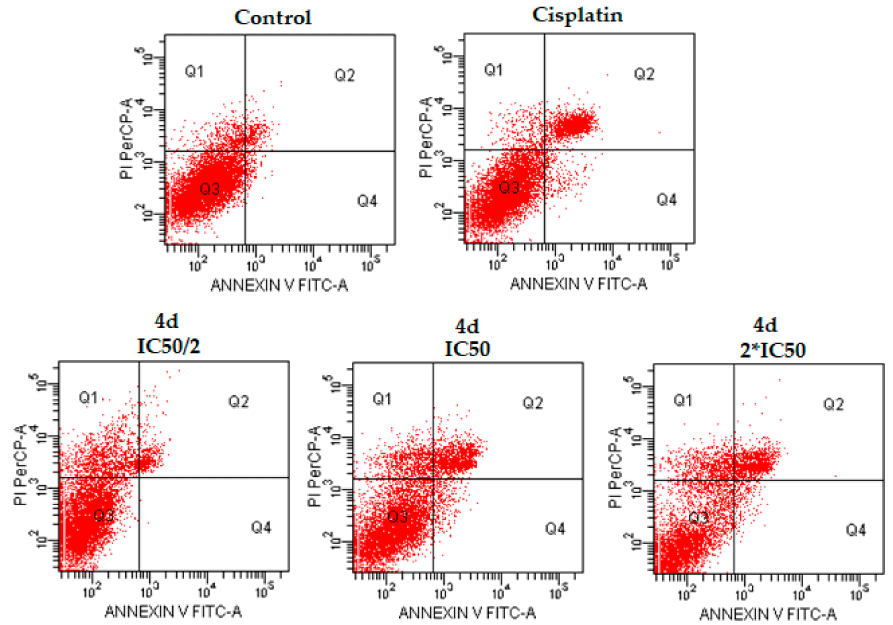
Figure 3. The flow cytometric analysis diagram of compound 4d and cisplatin for C6 cell line. Annexin V-PI analysis in C6 cell line, following 24 h incubation period of compounds 4d at IC 50 /2, IC 50 , 2 × IC 50 concentrations, which are 0.015, 0.03 and 0.06 mM, respectively, following 24 h incubation period. FITC Annexin V method in C6 cell line, following a 24 h incubation period of cisplatin at IC 50 (0.03